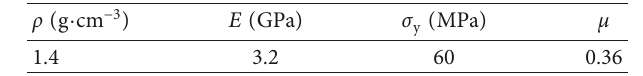
Table 3: Parameters of slotted pipe.